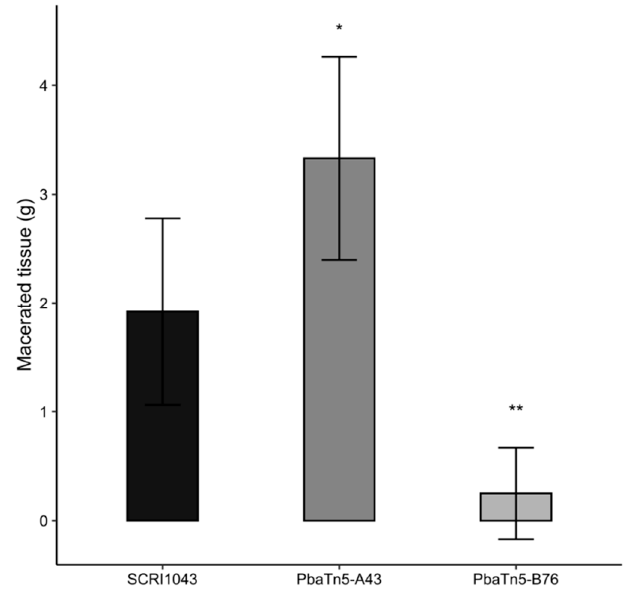
Figure 3. Maceration ability of the wild-type strain P. atrosepticum SCRI1043 and transposon mutant strains on potato tuber slices. The figure depicted only mutants where the level of potato tissue macerating ability was significantly different from that in wild-type P. atrosepticum SCRI1043. Bacteria (10 6 per inoculation) of the wild-type strain and mutant strains were inoculated into wells on potato tuber slices. The maceration capacity of mutants (in grams of macerated tissue) was measured after 72 h of incubation at 28 °C. The error bars represent the SD of the n = 6 potato tuber slices. Asterisks indicate statistically significant differences in the degree of maceration of the mutants compared with the wild-type strain P. atrosepticum SCRI1043 (** p < 0.01; * p < 0.05), determined by the Student’s t -test.